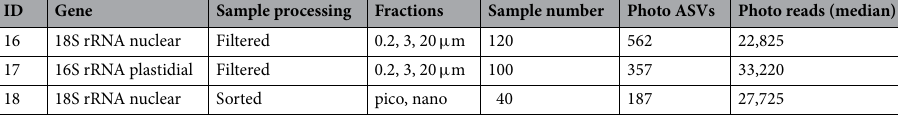
Sample processing